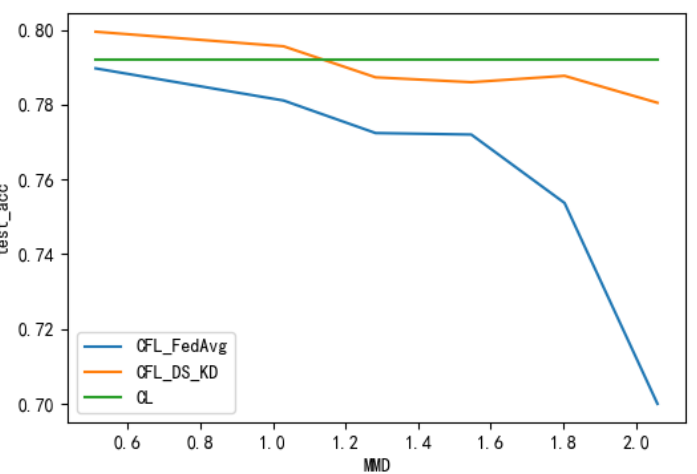
Figure 9. A performance comparison of the different methods under different MMD